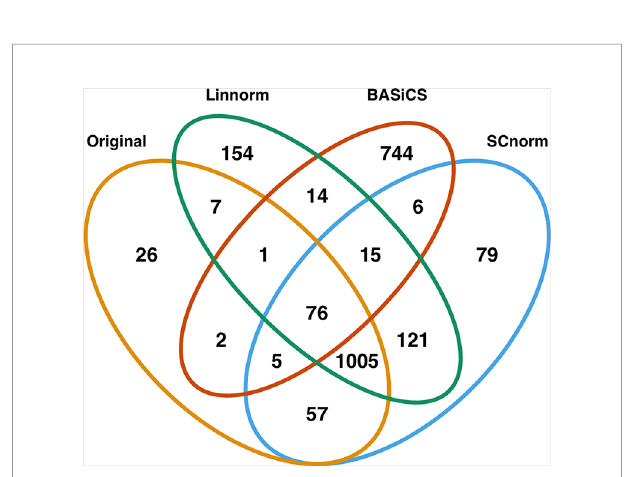
FIGURE 10 | Venn diagram of all DE genes detected at 0.05 signi fi cance level for the human embryonic data